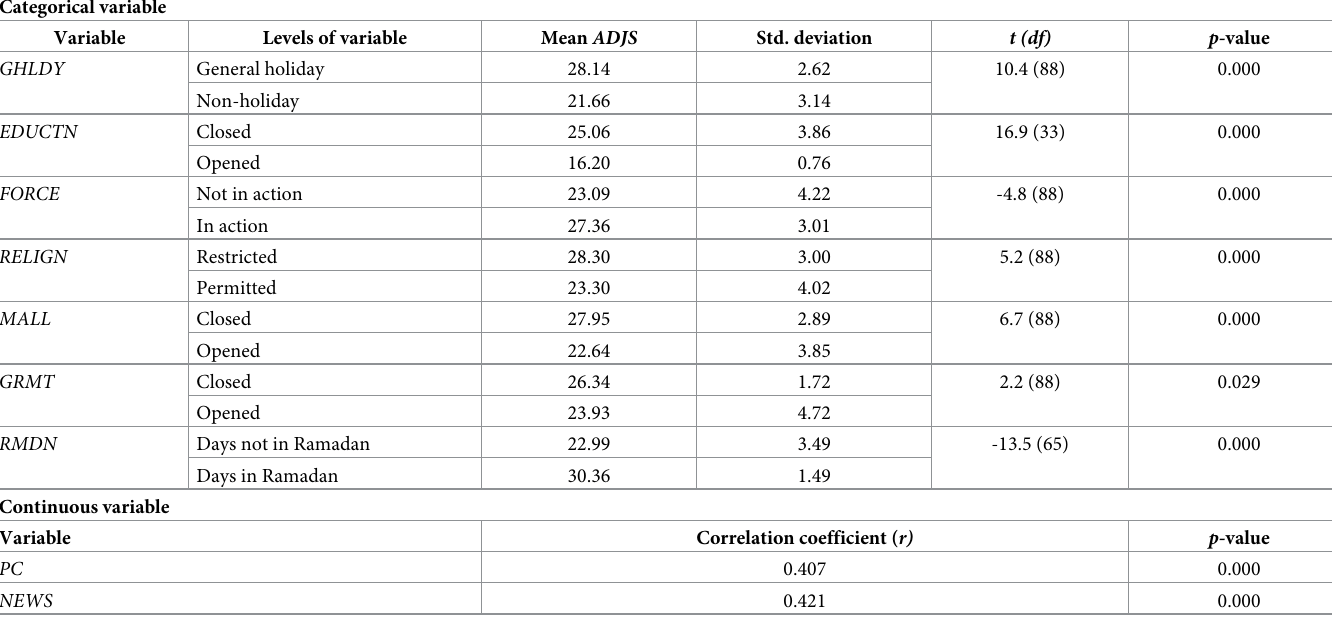
Table 2. Results of the univariate analysis (Relationship between dependent variable and each of the independent variables individually). Categorical